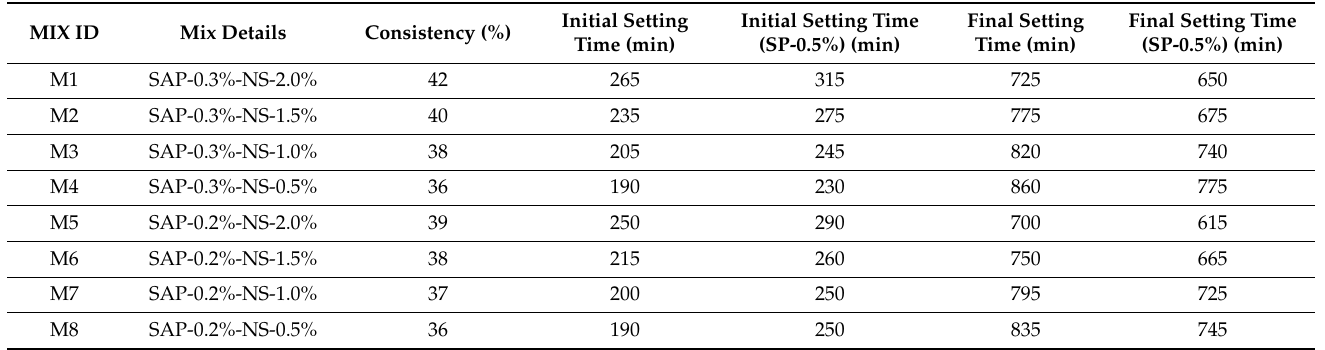
Table 1. Percentage of consistency and setting times of blended cement